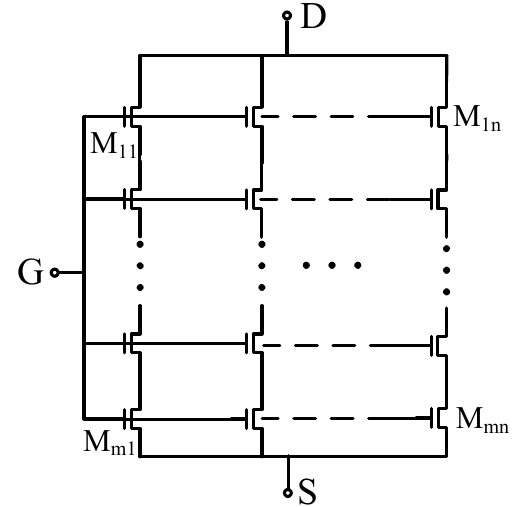
Figure 2. Schematic of the extended-gate field-effect transistor (EGFET) topology based on transistor association technique. Each element is characterized by a fixed W/L ratio.